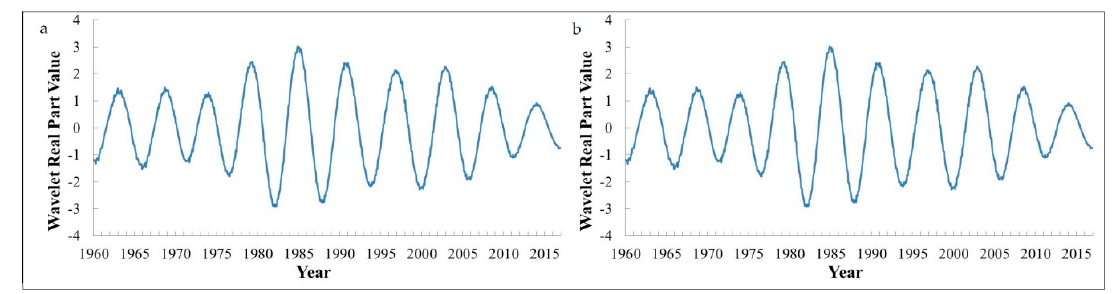
Figure 14. Wavelet time–frequency diagram on SPEI12. ( a ) Wavelet time–frequency diagram on the first main cycle; ( b ) Wavelet time–frequency diagram on the second main cycle.